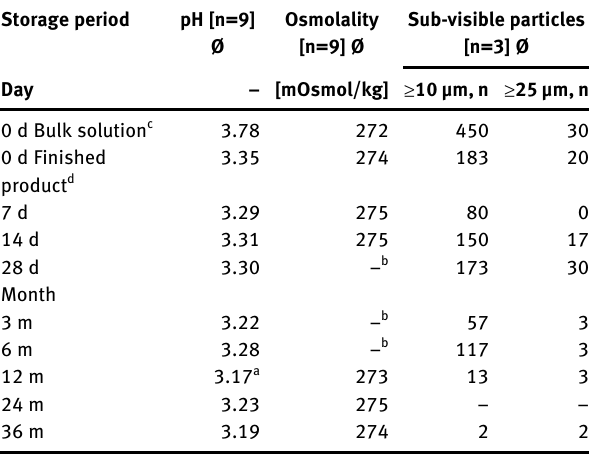
Table  : pH values, osmolality and sub-visible particles of E  .  mg/mL injection solutions in  mL amber glass vials stored at  –  ° C. Storage period